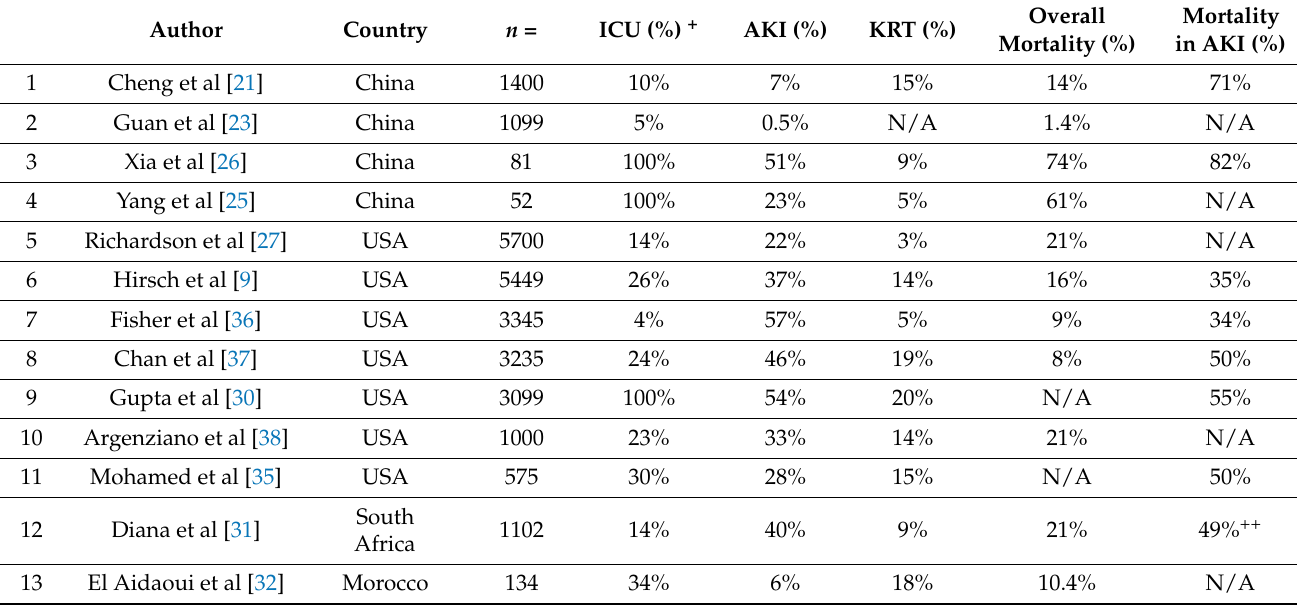
Table 1. Incidence and associated mortality in COVID-19-related acute kidney injury from large series across the world.